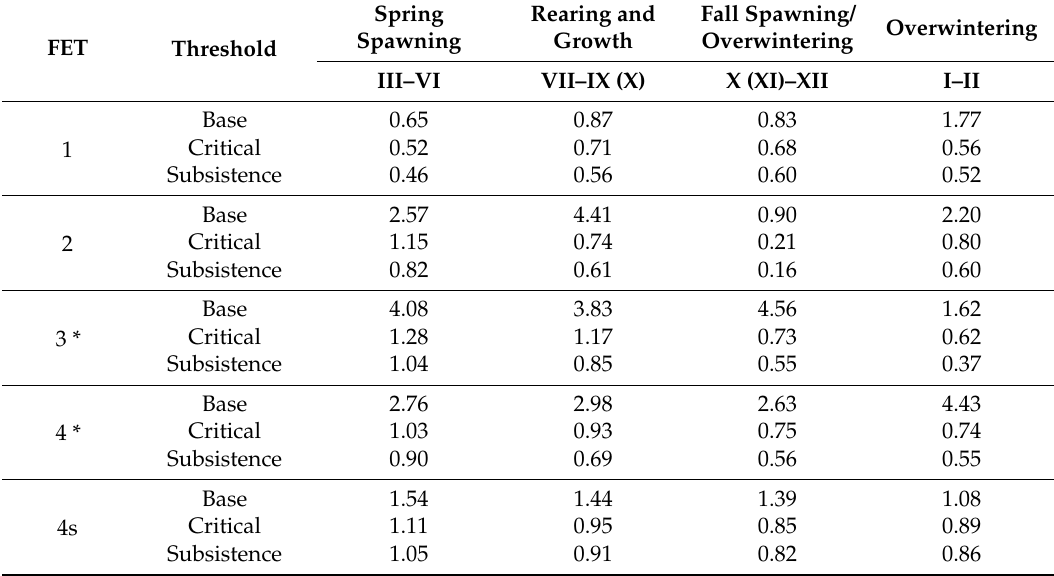
Table 4. FET specific coefficients p b for all three thresholds. I–XII—month. Star symbol indicates rivers where no fall spawning occurs. 4s indicates type 4 with salmonid spawning.